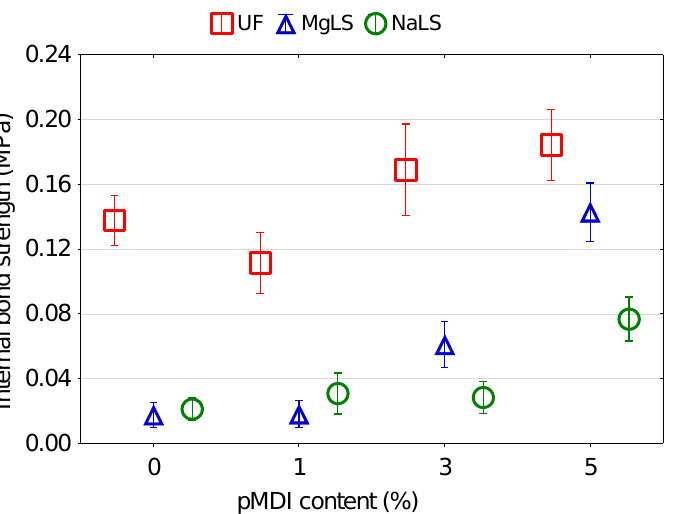
Figure 10. Effect of pMDI content on the IB of particleboards bonded with pure UF and lignosul- fonate adhesives.